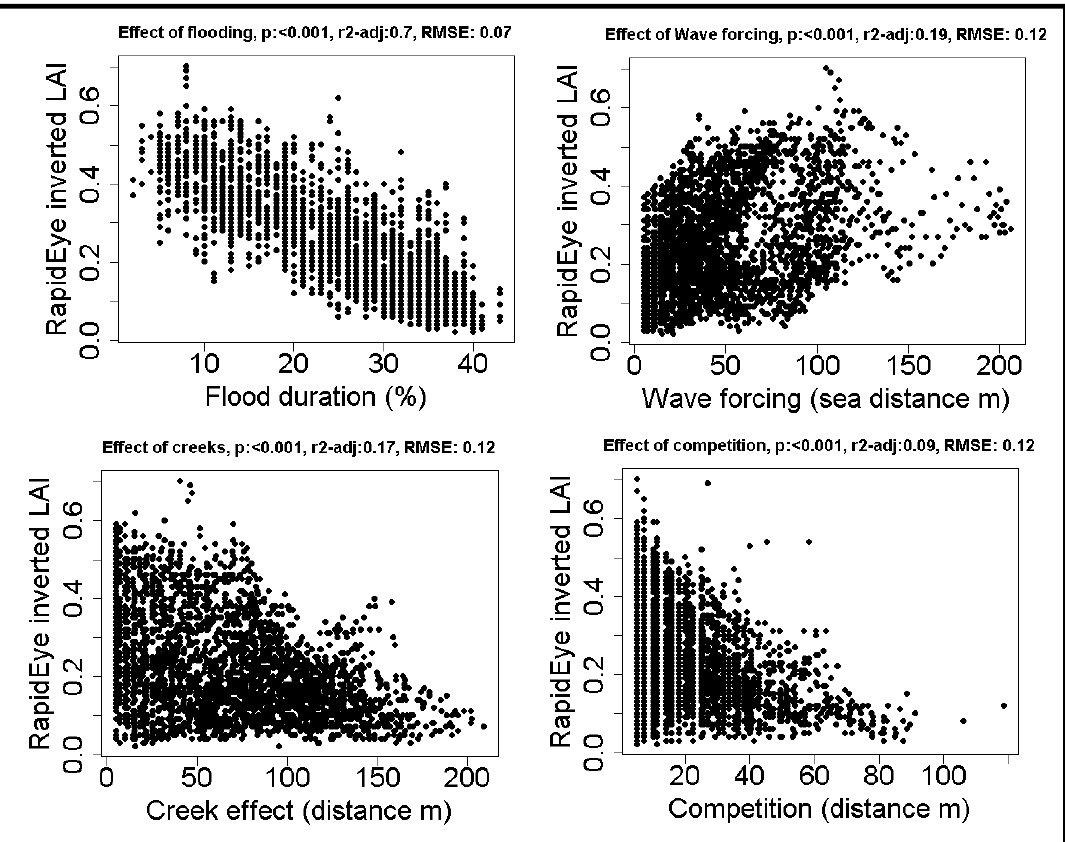
Figure 4. The large scale effects of the spatial drivers on salt marshes: relationships between drivers and Leaf Area Index (LAI) obtained from inversion of RapidEye satellite images.